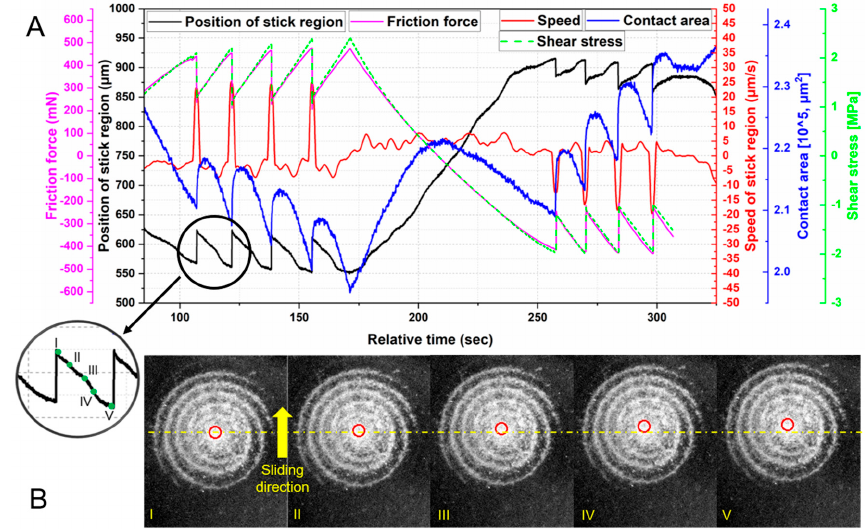
Figure 9. ( A ) Relationship of the movement of stick region, friction force, contact area, and shear stress of the first cycle in the 5 µm/s test; ( B ) Marked stick region within one stick phase (I, II, III, IV, V) using machine learning.